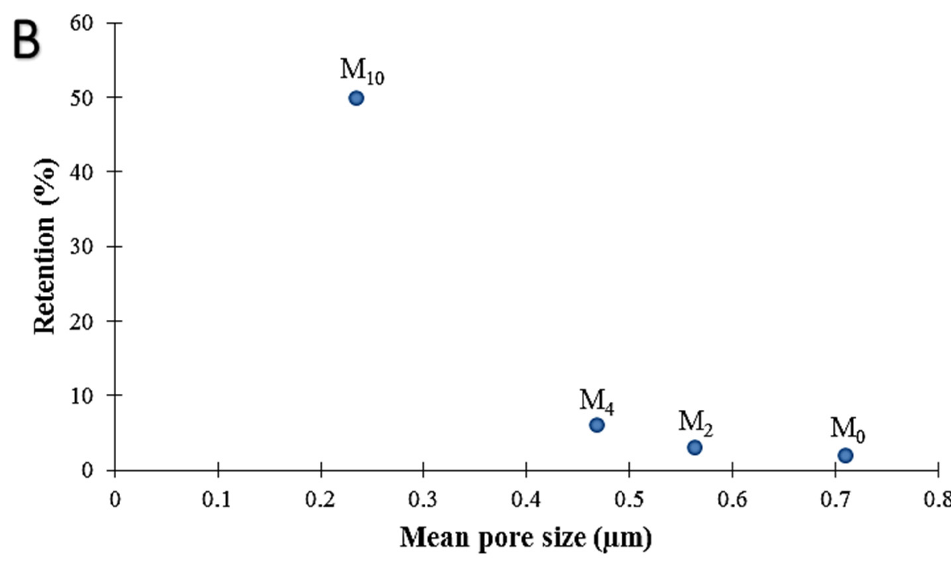
Figure 12. The influence of gelation time on retention (( A ): retention vs. gelation time, ( B ): retention vs. mean pore size).